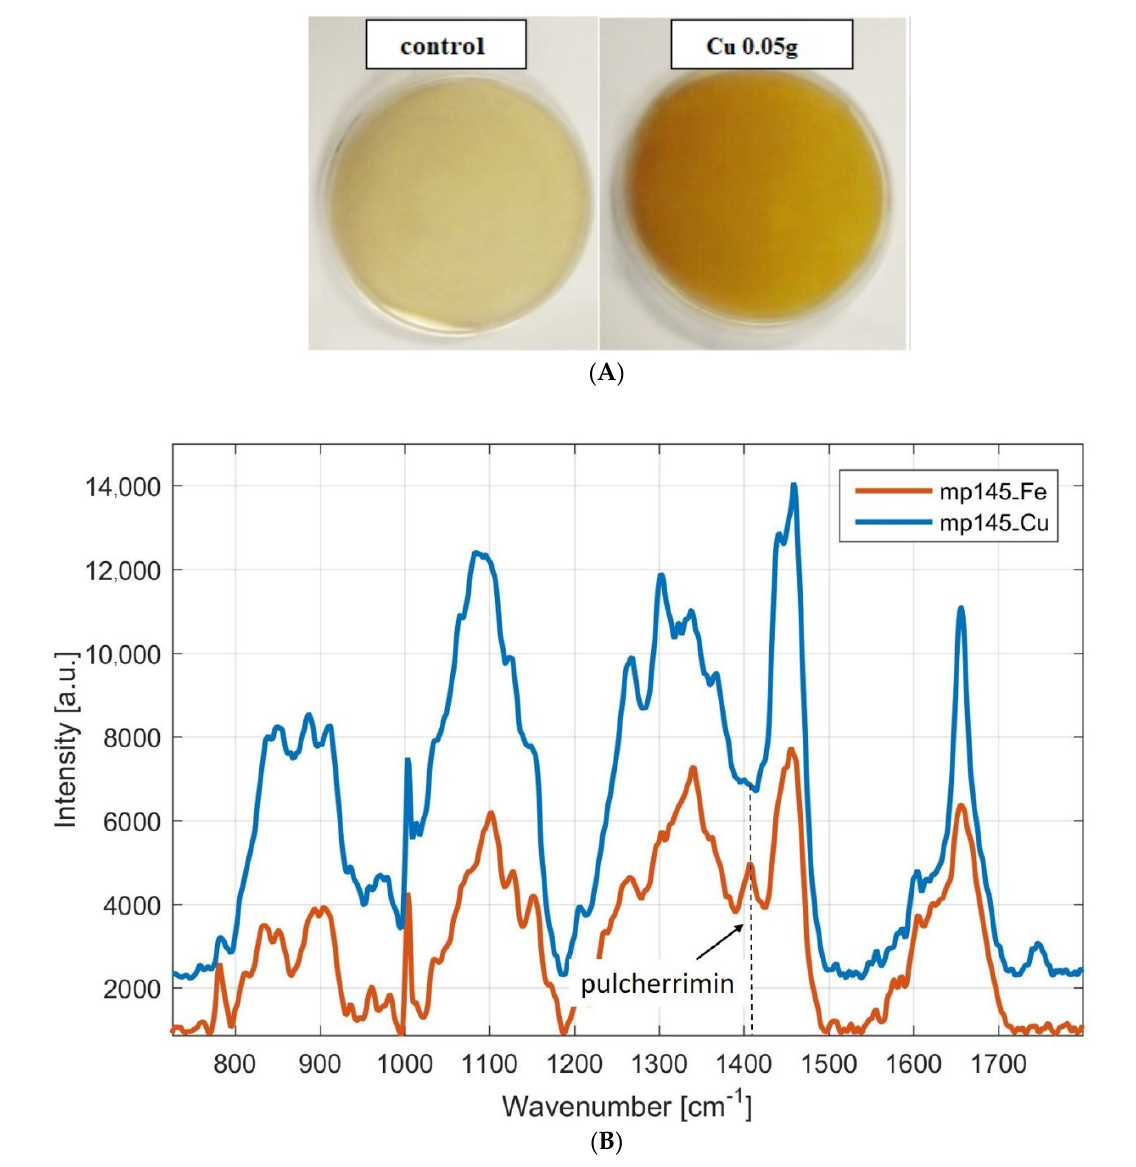
Figure 4. ( A ) Color changes in Metschnikowia pulcherrima 145. Copper-ions were added to the media which is characterized by the media dark yellow color change (CuSO 4 0.05 g/L). Control is medium without metal ions. ( B ) Raman spectra of pulcherrimin produced by yeast Metschnikowia pulcherrima MP 145 on Cu-containing medium and medium with iron ions. Legend: Metschnikowia pulcherrima 145 cultivation on medium with 0.05 g/L Fe (mp145_Fe, red trace) and medium with 0.05 g/L Cu (mp145_Cu, blue trace). Spectra are vertically shifted for clarity.